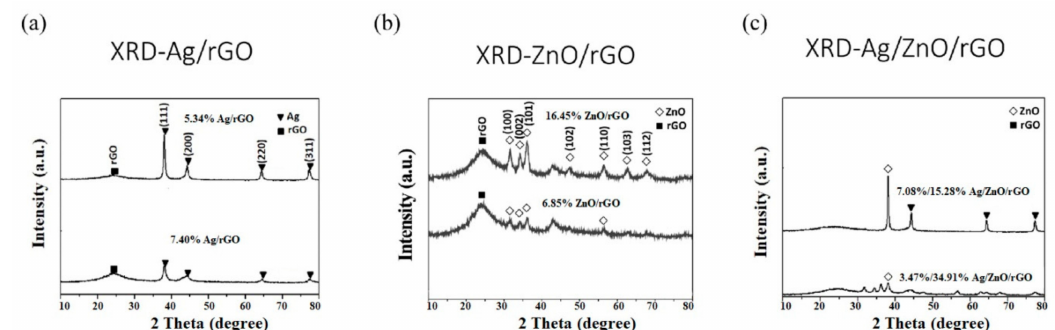
Figure 2. X-Ray di ff raction analysis. ( a ) Silver nanoparticle-embedded graphene oxide (Ag / rGO), ( b ) zinc oxide nanoparticle-embedded graphene oxide (ZnO / rGO), and ( c ) silver nanoparticle and zinc oxide nanoparticle-embedded graphene oxide (Ag / ZnO / rGO). Black square ( (cid:4) ), rGO; white diamond ), ZnO; black triangle ( (cid:72) ), Ag. Data are representative of two separate experiments. (cid:51)